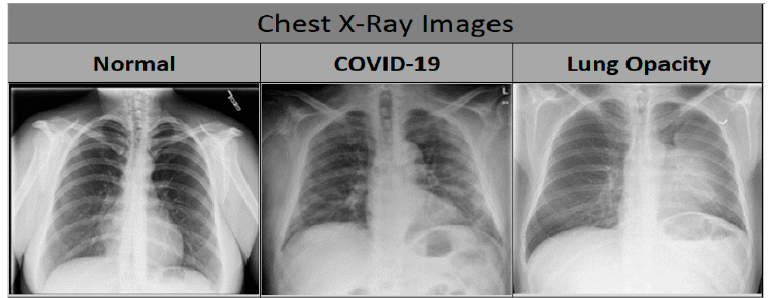
Figure 1. Sample chest X-ray images of normal, COVID-19 and lung opacity cases.